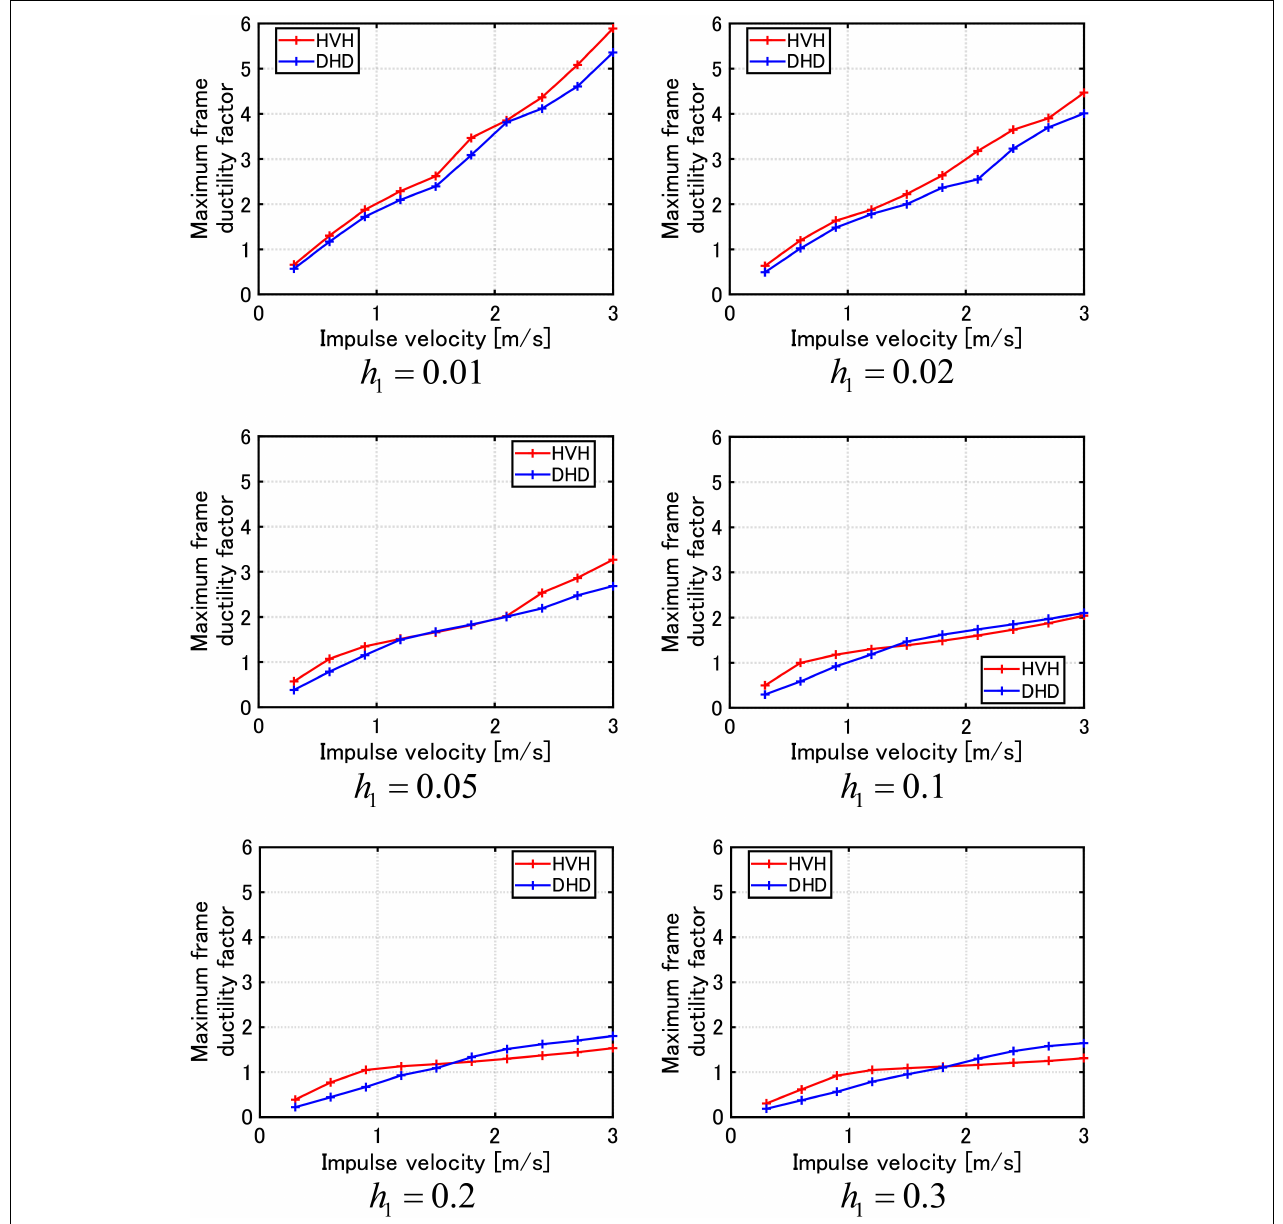
FIGURE 11 | Maximum frame ductility factor with respect to input velocity level of double impulse for MDOF systems with HVH system for various damping levels